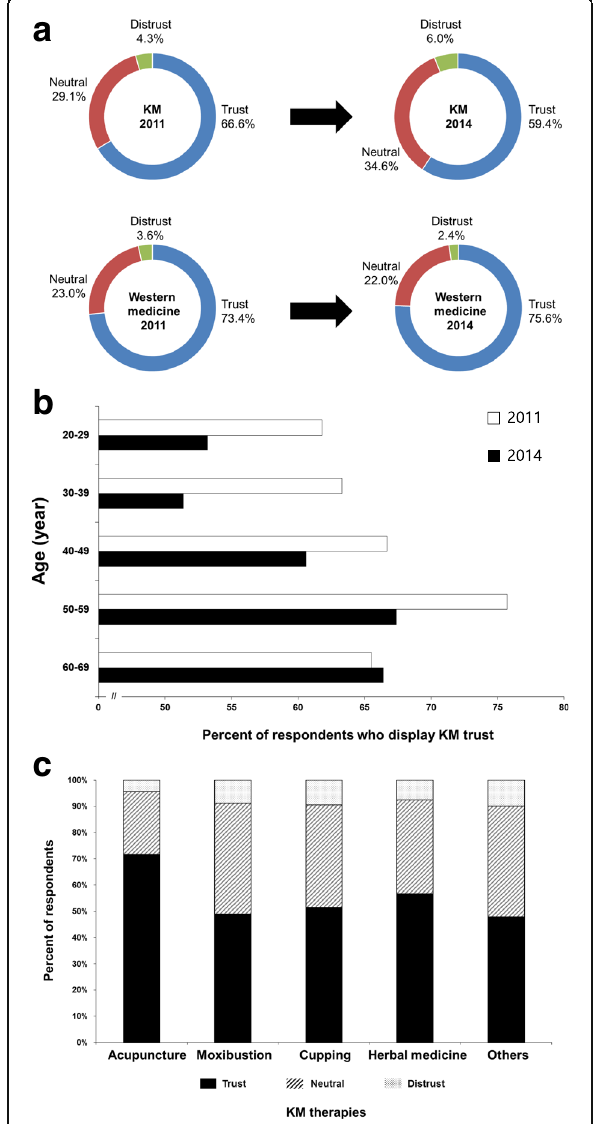
Fig. 1 Reduction in KM trust between 2011 and 2014 . a KM trust decreased from 66.6 to 59.4%. By contrast, trust in Western medicine was nearly the same between 2011 and 2014. b The decrease in KM trust appeared in all age groups, except for participants in their 60s. Favorable perceptions were reduced more significantly among members of the general public in their 20s and 30s than in any other age groups. The 2011 survey data were obtained from Woo et al. [11]. c The respondents perceived that acupuncture was the most trustable among the KM therapies. Regarding other KM